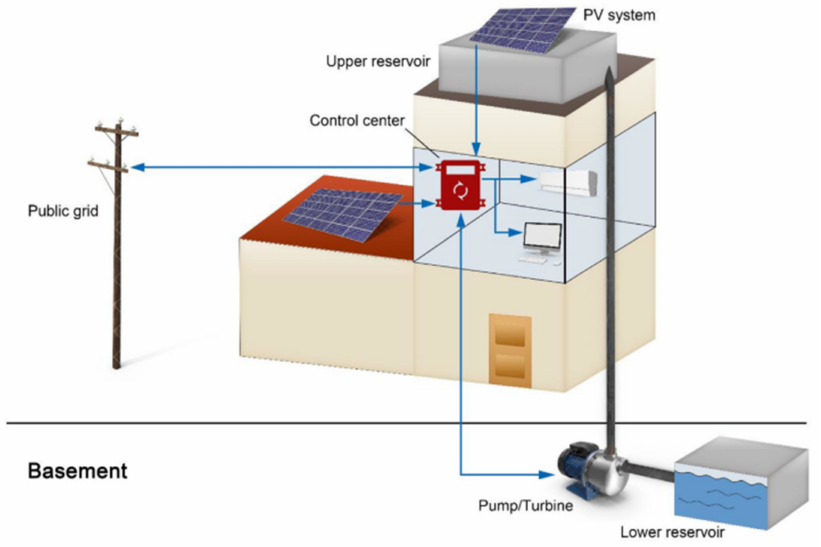
Figure 2. Configuration of the PV arrangement with the hydro-pump system [4]. No changes were made to the original